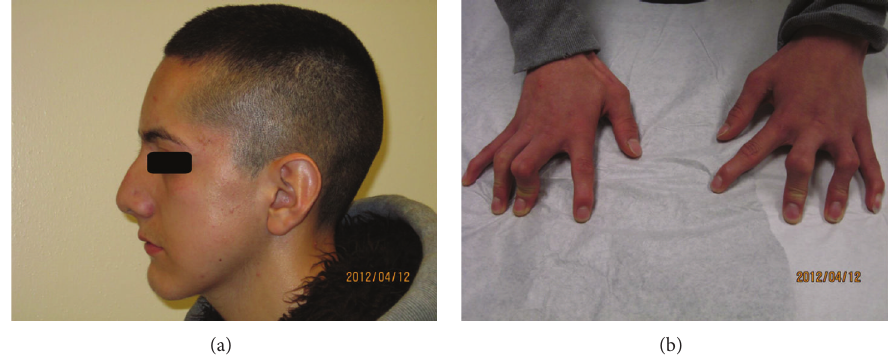
Figure 1: Pictures of the patient showing: (a) facial dysmorphic features and (b) campylodactyly.